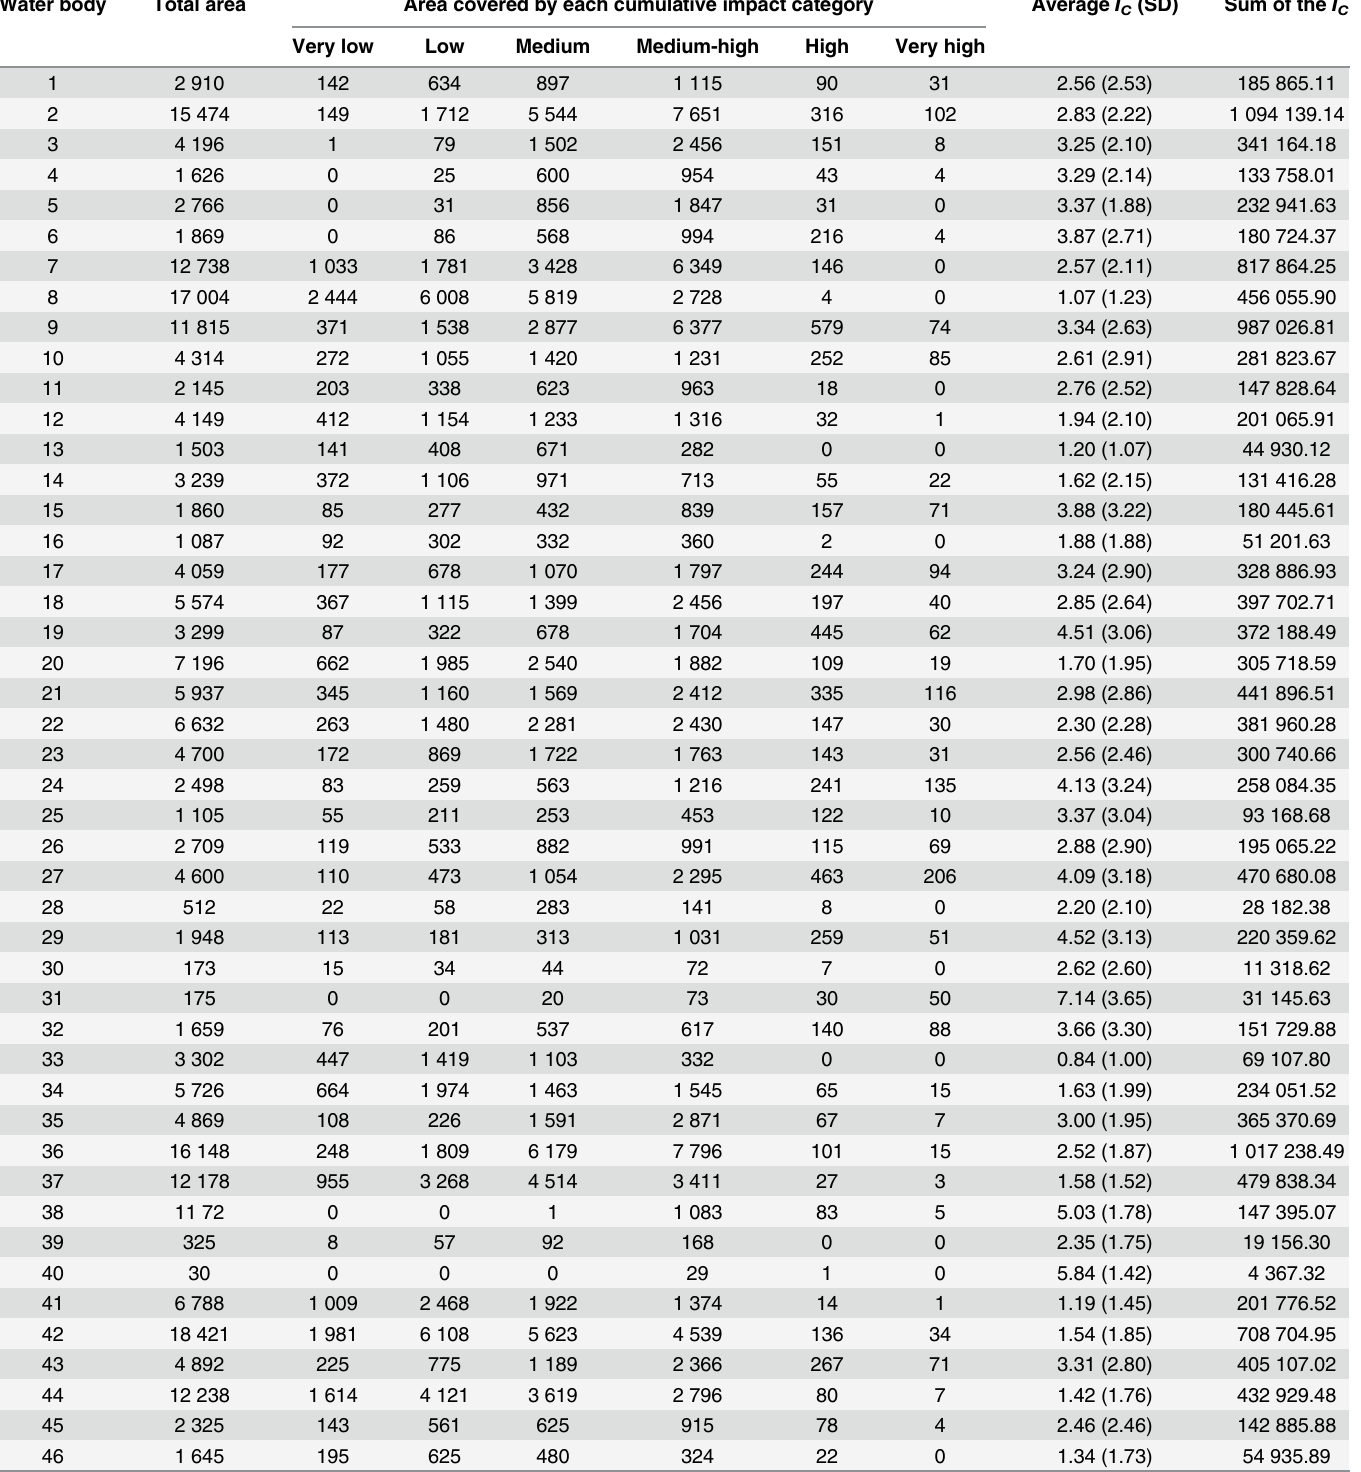
Table 3. Analysis of the pressures per water body. For each water body, the table describes its total area, its area covered by each cumulative impact score ( I C ) category (very low, low, medium, medium-high, high, very high impact), the average and standard deviation (SD) of I C and the sum of the I C obtained by each 20 x 20 m cell composing the water body. Coastal water bodies are numbered from West to East. Areas are indicated in